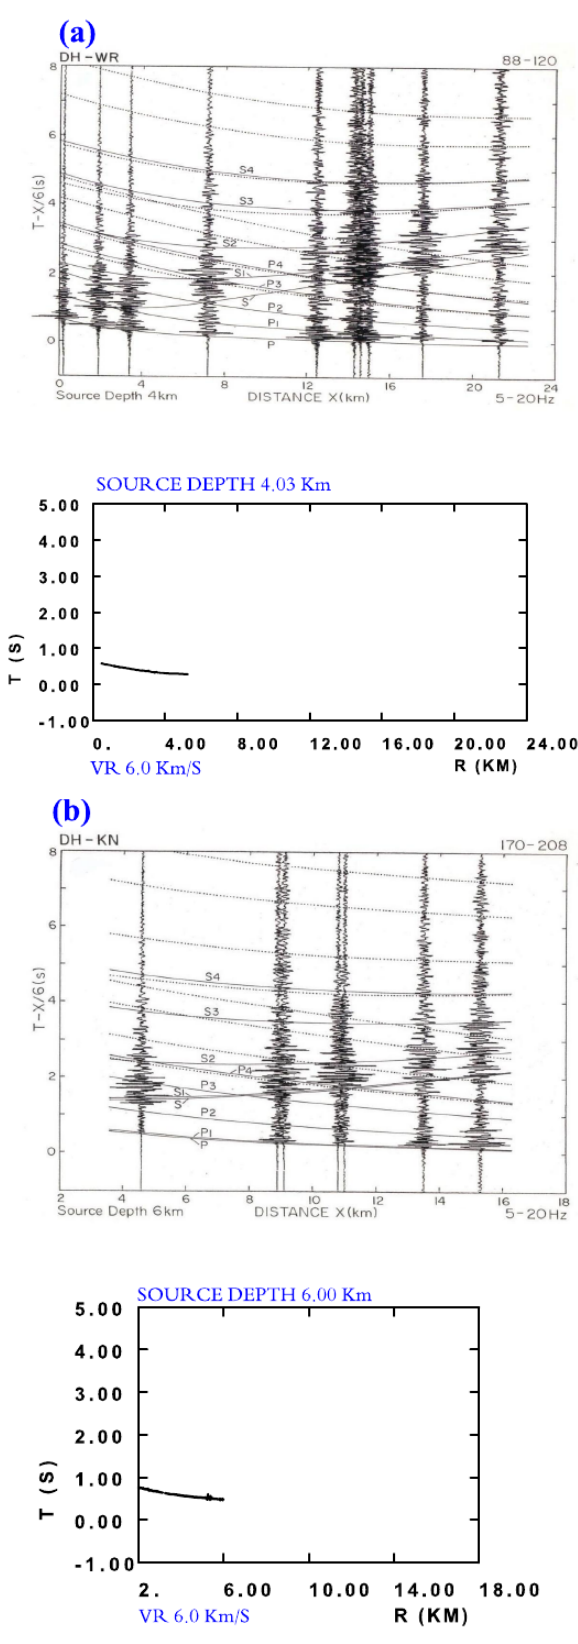
Figure 14. Two record sections compiled in the region in the pres- ent study, using the recordings at DH-WR stations for a source depth of 4 km and at DH-KN stations for a source depth of 6 km. The P and S travel time curves for the ray paths as given in Figure 11 are also given in these two record sections. The direct P travel time curves computed for the model given by Dixit et al. [2014] are also indicated below these record